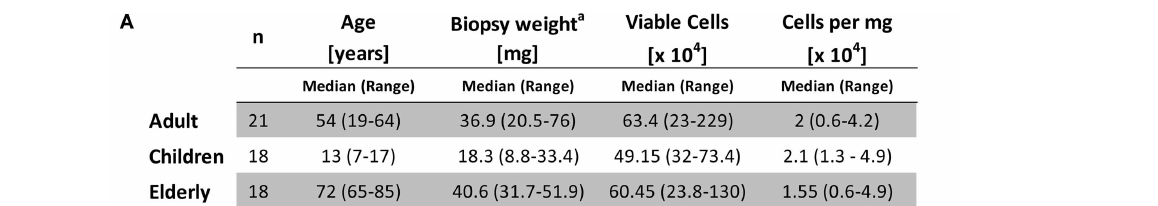
FIGURE 2 | Cell yields from gastric biopsies (LPMC) from different age groups . (A) Comparison of biopsy weight and viable cell yields obtained from children, adults, and the elderly.Trypan blue exclusion was used to enumerate live viable cells. (B) Cell yields were expressed as total viable cells per